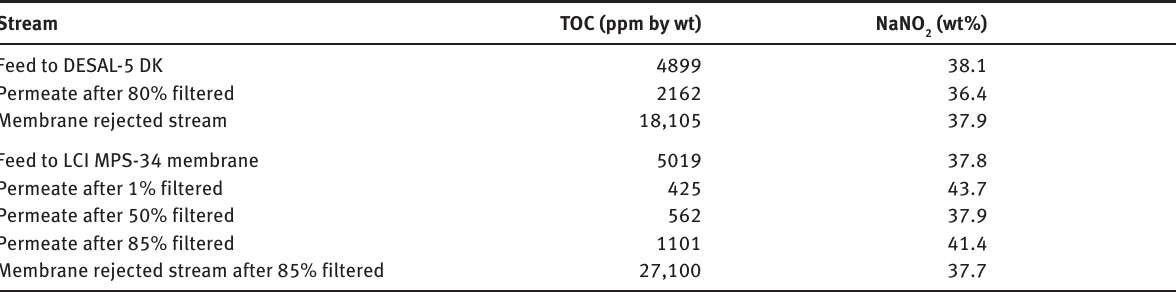
containing ~5000 ppm total organic carbon (TOC). 2